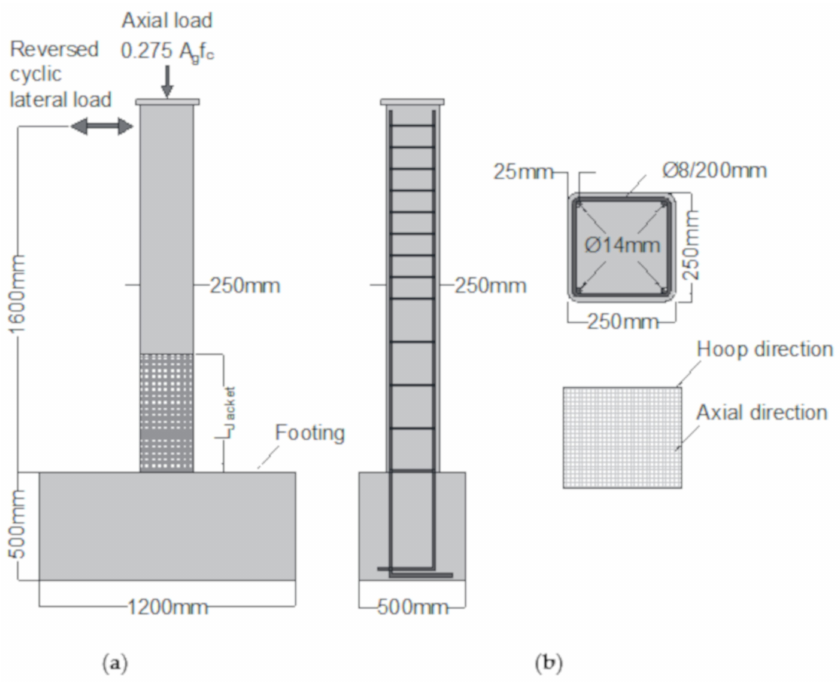
Figure 1. ( a ) Schematic of test set-up; ( b ) cross-section and textiles orientation. Bournas